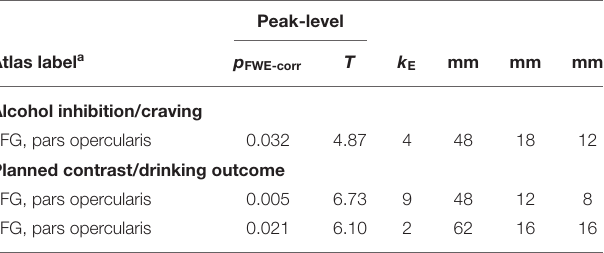
TABLE 2 | SPM output listing significant cluster with statistics and MNI-coordinates of the regression analyses investigating gray matter whole brain relationships of inhibition activation and craving as well as drinking